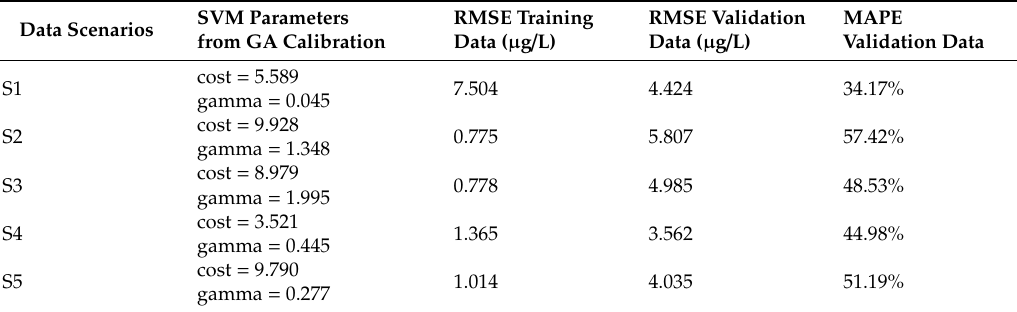
Table 4. Parameters and accuracies of the SVM models under the five data